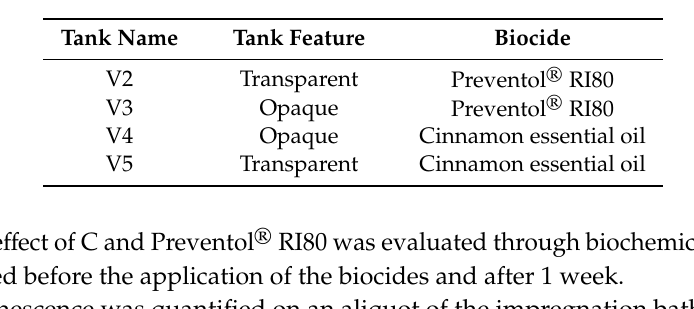
Table 2. Details of the experimentation carried out during the consolidation of wooden